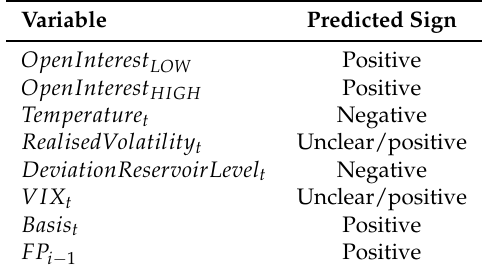
Table 2. The predicted signs of the coefficients in the regression